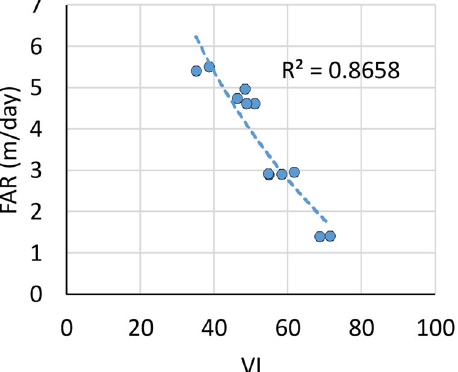
Fig. 5 Relationship between mean of VI’s and FAR in each panel, a logarithmic regression